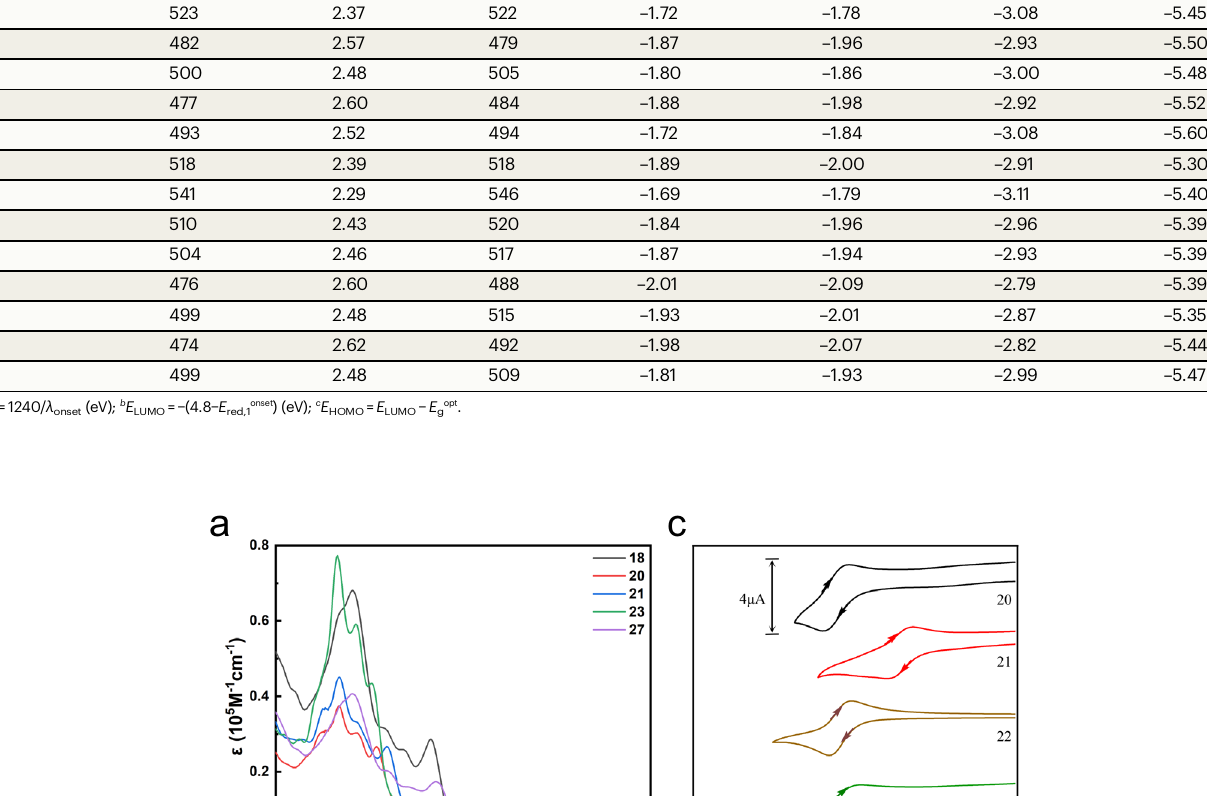
Table 1 | Properties of curved nanographenes Nanographene